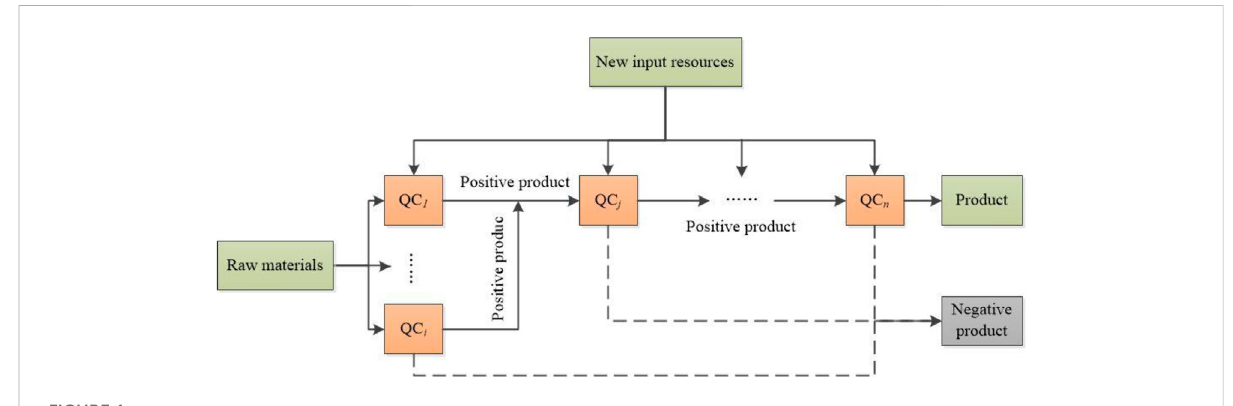
FIGURE 1 Process of material fl